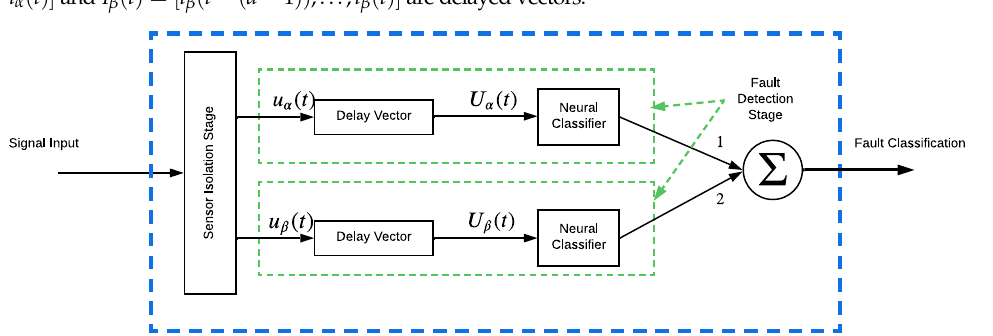
Figure 7. Configurationofallneuralnetworksusedtoclassifyfaultsofactuatordata. U α ( t ) = [ u α ( t − ( d − 1 )) ,...,